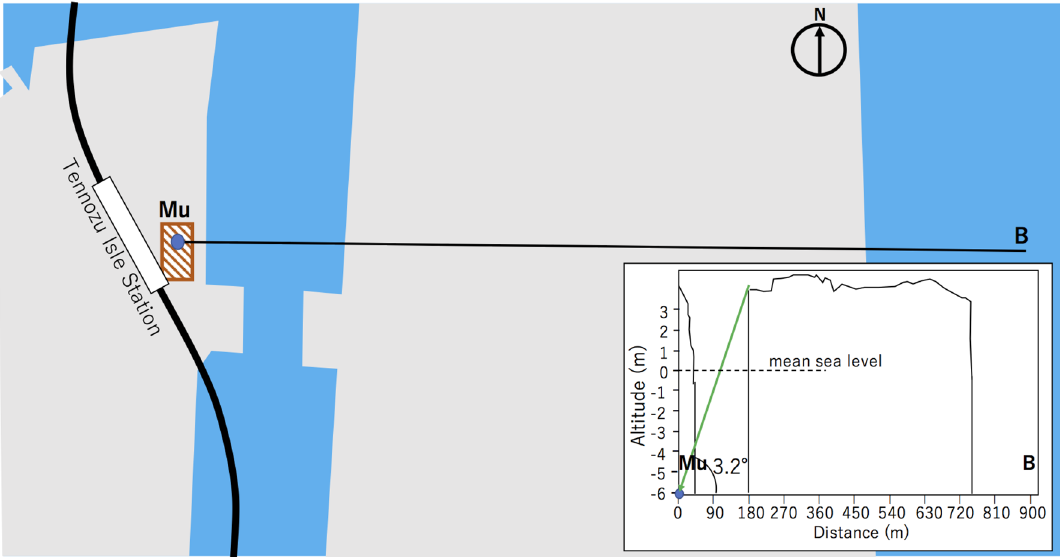
Figure 6. Enlarged map near the region of (1) in Fig. 4. The red shaded rectangle indicates a commercial building having a basement floor located 10 m below the ground surface. The label Mu indicates the location of the HKMSDD-MSM. The inset shows the cross-sectional view along the Mu-B line as an example of the vertical cross-sectional configuration of the measurement. The elevation scale is magnified by 50 times compared to the horizontal scale. HKMT drew this map with Microsoft PowerPoint software and holds the copyright.